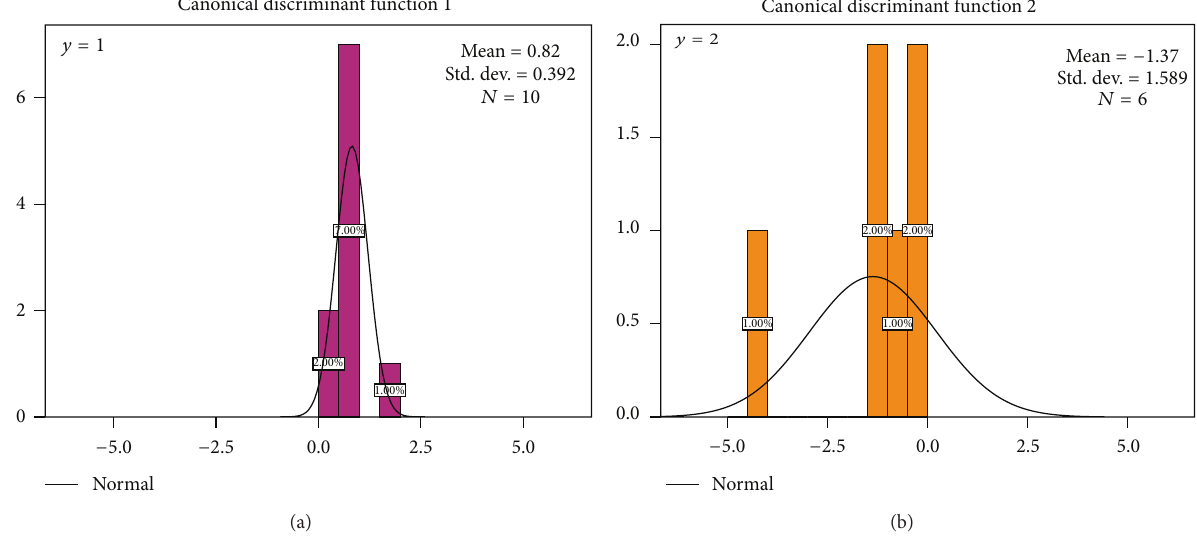
Figure 5: The plots of linear discriminant analysis. (a) Normal distribution of ten A.chinensis samples; (b) normal distribution of six A. lancea .